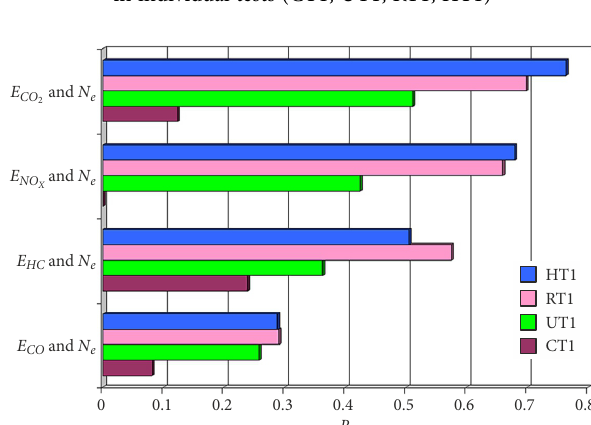
Figure 15. Coefficient of Pearson’s linear correlation r between the pollutant emission intensity ( E CO and the non-negative effective power of the engine N e in individual tests (CT1, UT1, RT1, HT1)